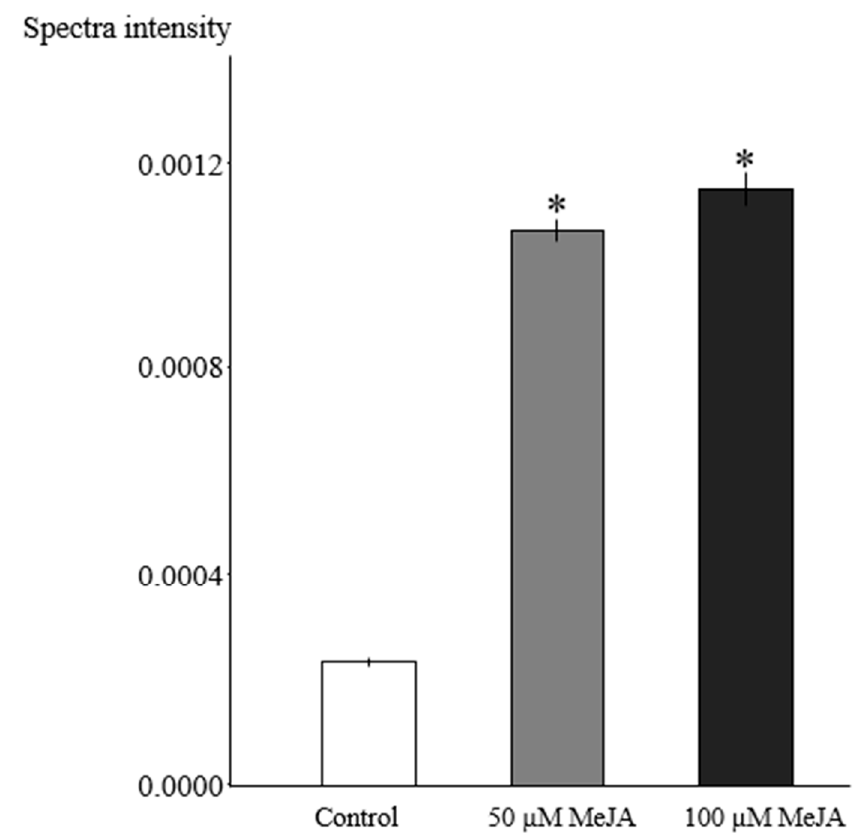
Figure 4. Comparison of total vindoline-type alkaloid based on 1 H-NMR data in MeJA-elicited (50 and 100 µ M, for three days) R. stricta hairy roots and control cultures (equal volumes of 40% ethanol were added as in 100 µ M MeJA). The sum of the values of spectral intensity from 1 H NMR bucket data in the region δ 0.49– δ 0.54 (ppm) was used for quantification of total vindoline-type alkaloids. Pairwise comparison of means from two groups (control versus elicited sample) is presented as mean ± SD of three samples for each treatment. * indicates significant di ff erence in the mean between control and elicited sample (student’s t test, p < 0.05).